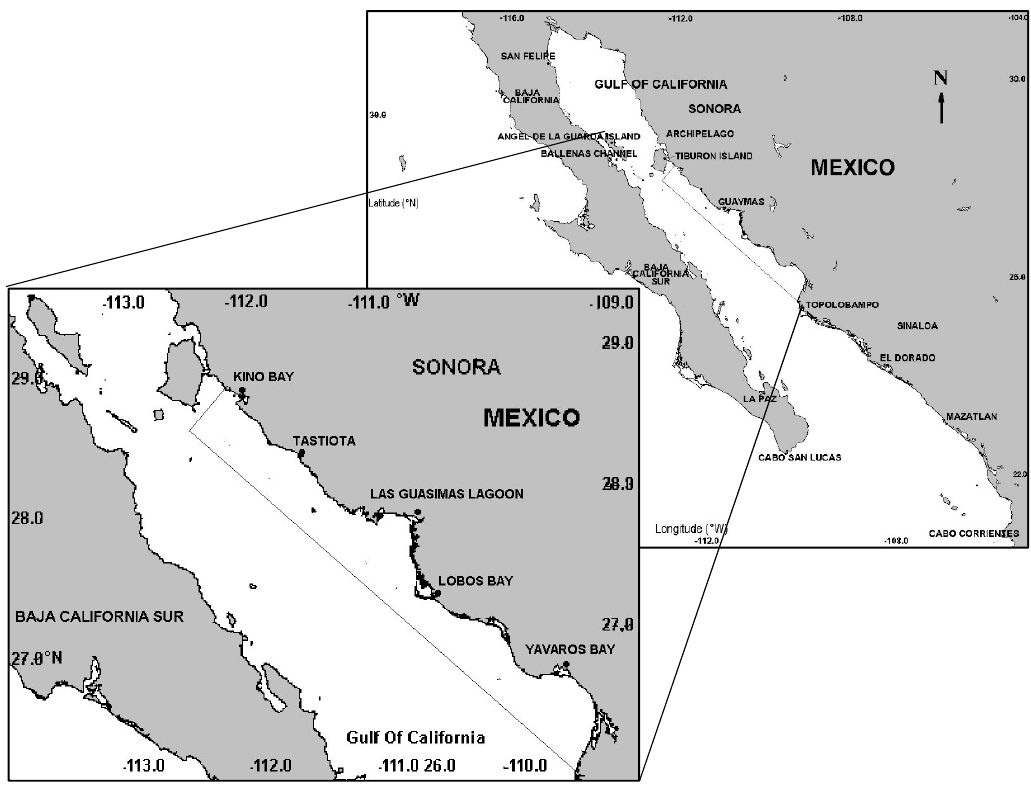
Figure 1. Central and southern coastal zone of Sonora in the Gulf of California and regionalization (continuous line) for environmental and oceanographic analyses.